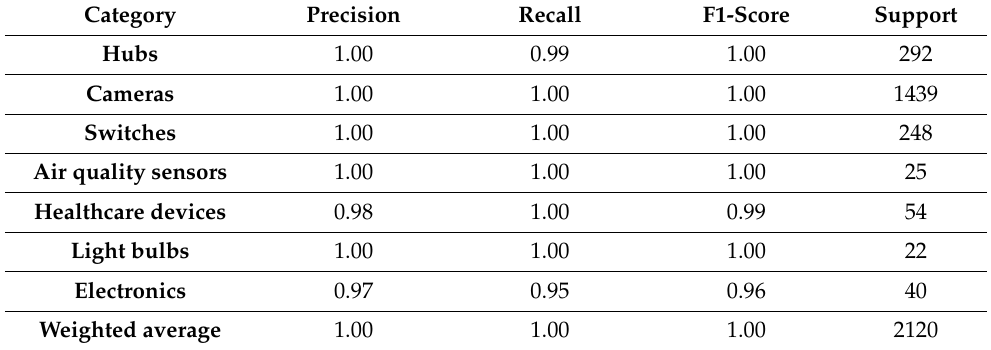
Table 7. The precision, recall, and F1-score results and numbers of test data for category.